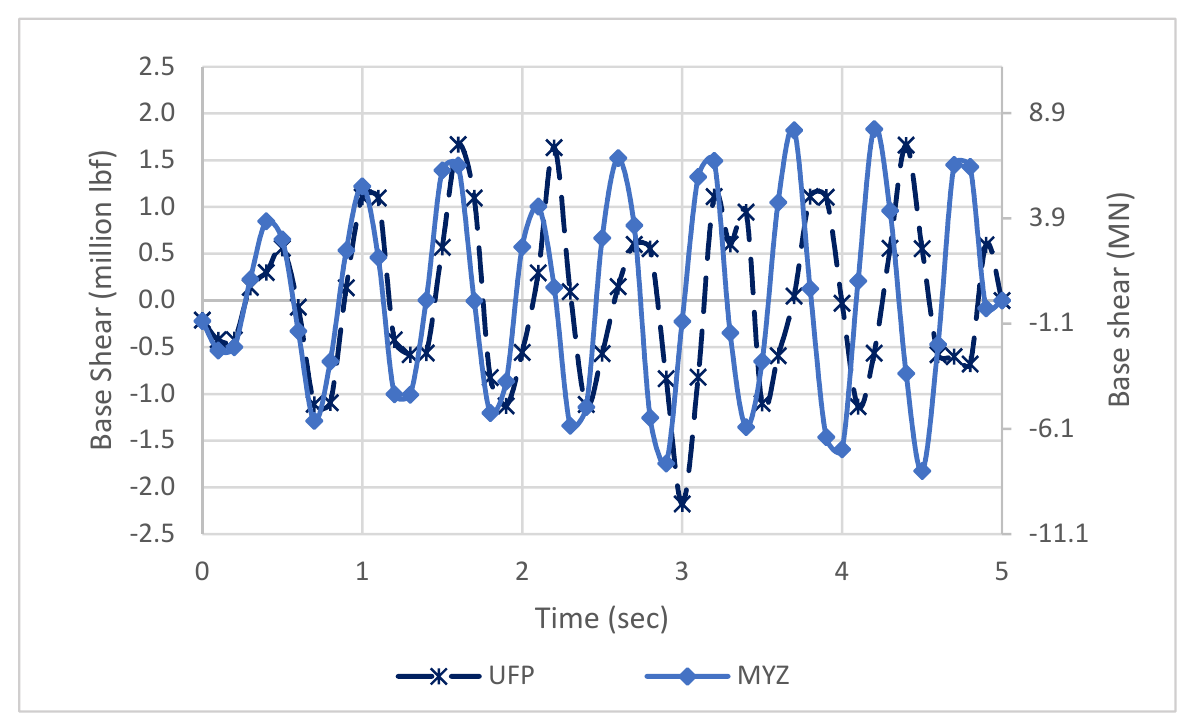
Figure 21. Base shear for UFP and MYZ.